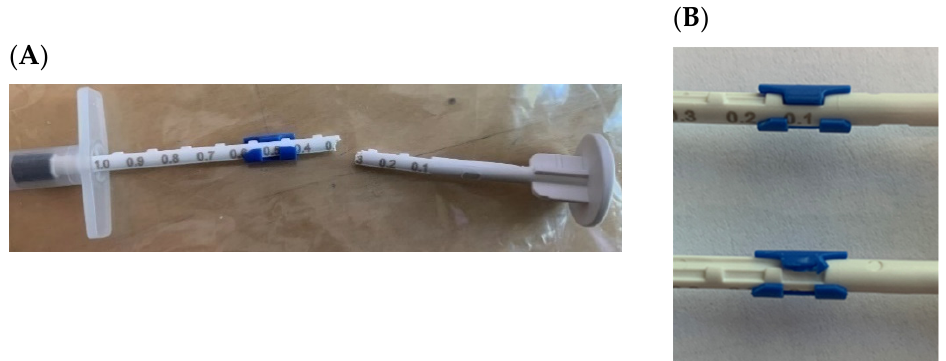
Figure 3. ( A ) Picture of a broken plunger rod. Participant stated the plunger rod broke as they were setting the dose. ( B ) Picture of a broken dose clip. Participant stated that the dose clip broke and would no longer remain in place.